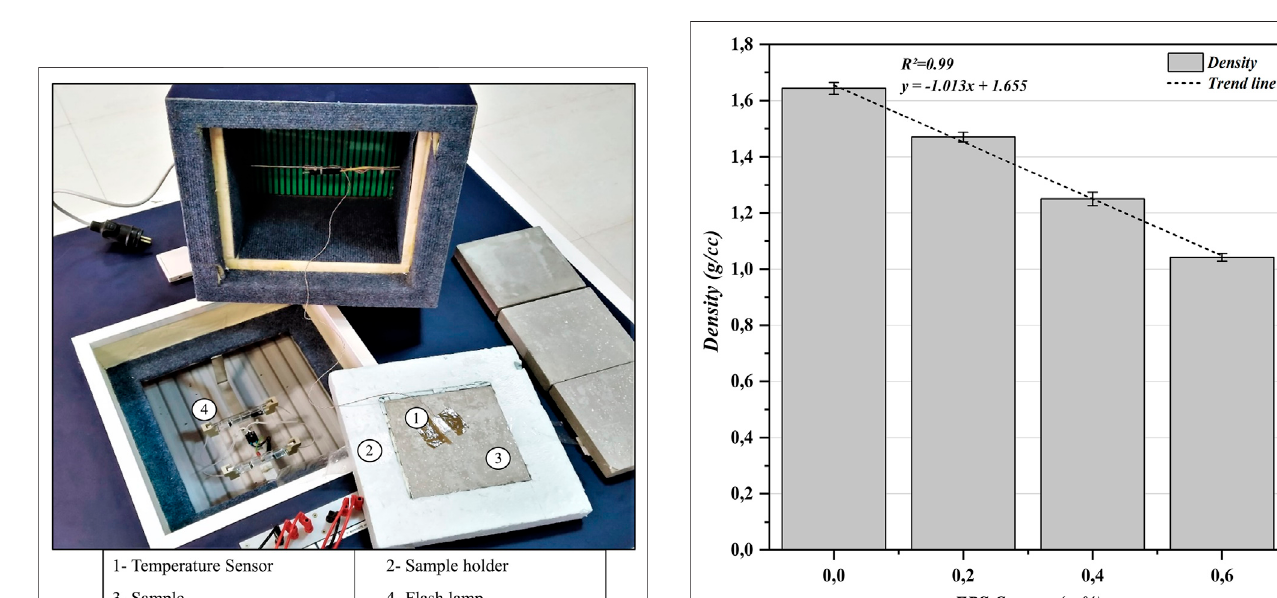
FIGURE 2 | Hot disk method setup.